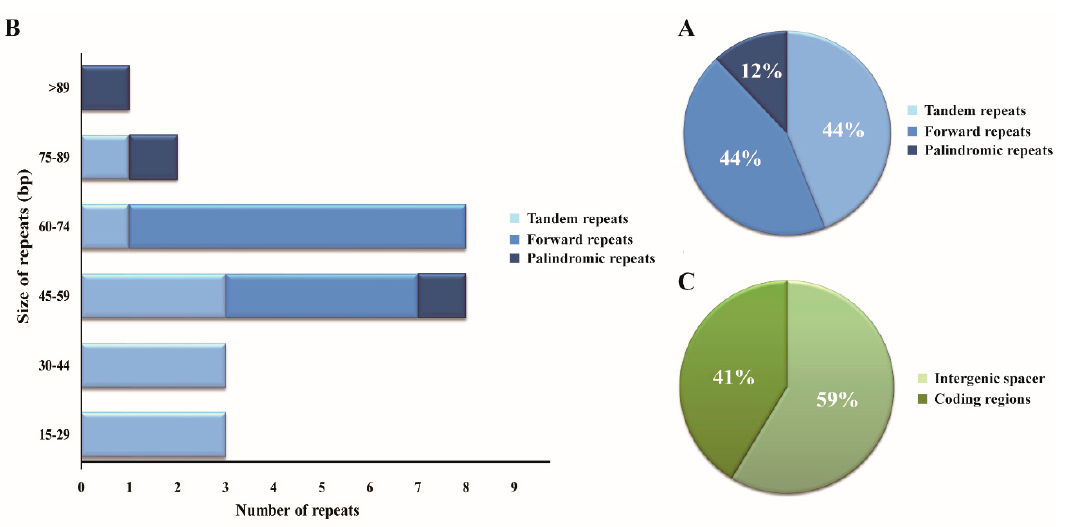
Figure 3. Analyses of repeat sequences in F. hodginsii cp genome. ( A ) Occupation of the three kinds of sequences. ( B ) Frequency distribution of tandem repeats, forward repeats, and palindromic repeats. The cutoff value was 15, 30, and 30 bp, respectively. ( C ) The proportion of regions containing repeat sequences.